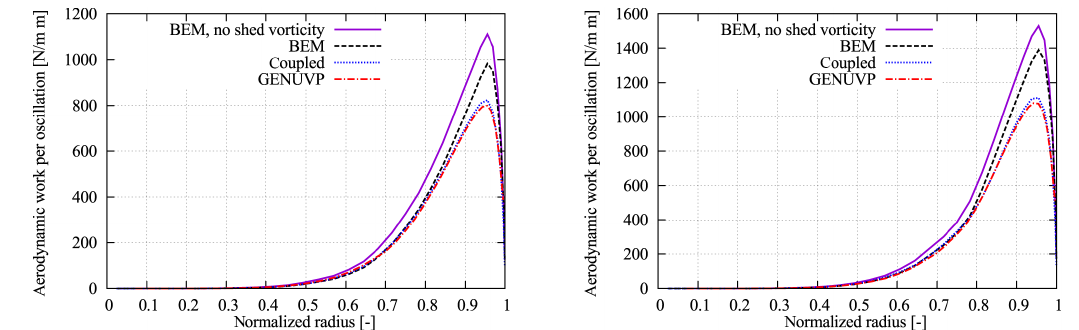
Figure 17. Aerodynamic work per oscillation of first flap motion at 8ms − 1 (left) and 25ms − 1 (right) wind speed with an amplitude of 0.5m.